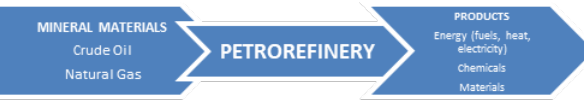
Fig. 2. Basic schema of classic refinery plant [4]